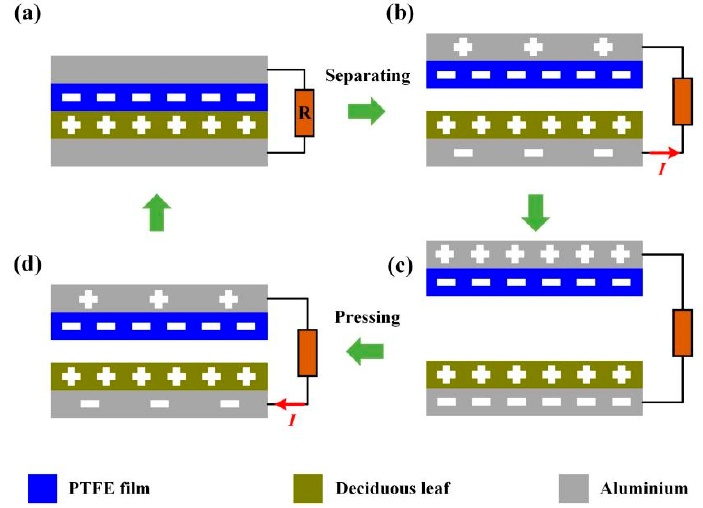
Figure 2. The operating principle of DL-TENG. ( a ) When the triboelectric pairs (PTFE film and deciduous leaf layer contact, positive charges and negative charges are produced on the surface of deciduous leaf layer, respectively. When the triboelectric pairs are ( a – c ) separating and ( c – a ) approaching, an internal field electrical field will be established which introduces the charges transferring between two electrodes.